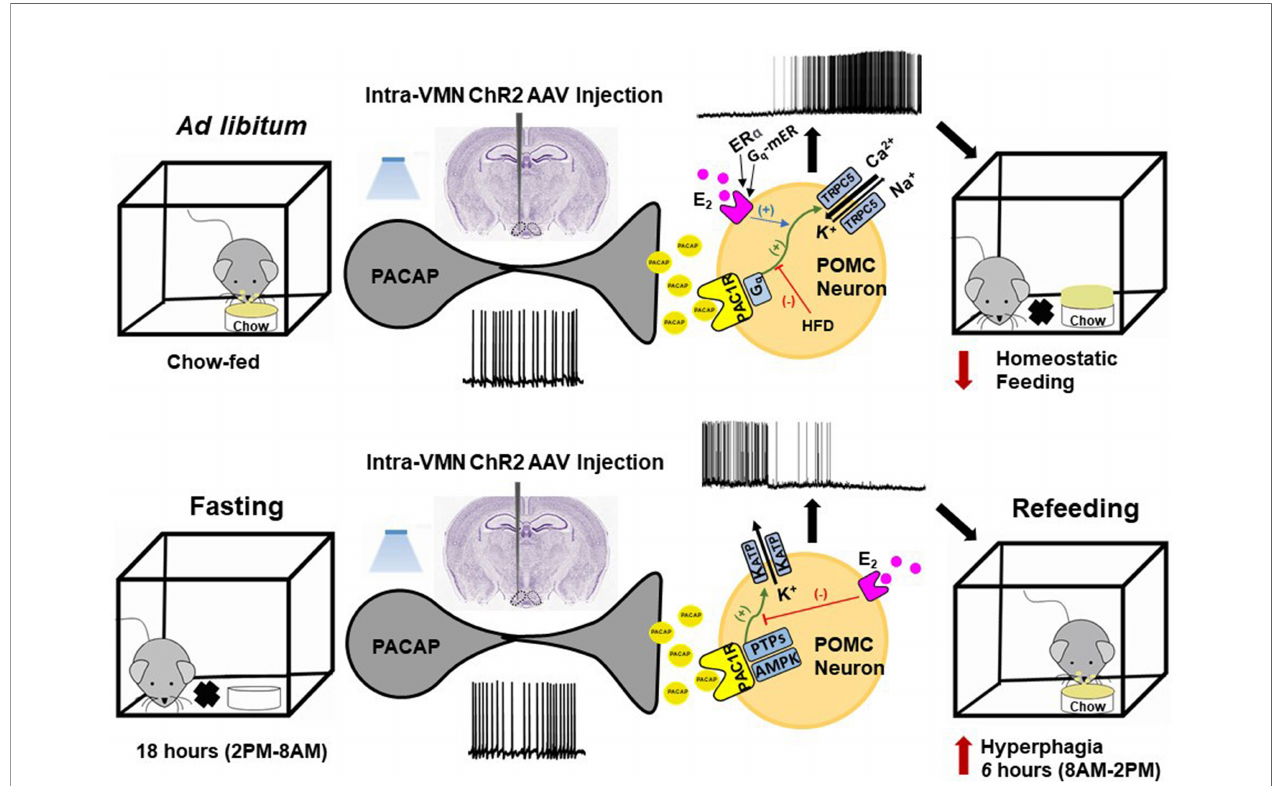
FIGURE 3 | Schematic overview of the energy status-dependent plastic changes in PAC1 receptor-mediated signaling at VMN PACAP/ARC POMC synapses. Top row , Under ad libitum -fed conditions, optogenetic stimulation of VMN PACAP neurons and subsequent release of PACAP stimulates PAC1 receptors in ARC POMC neurons, which in turn activates TRPC5 channels via G q -mediated signaling. This depolarizes the POMC neurons and increases their fi ring, and ultimately decreases homeostatic feeding. These effects are potentiated by membrane-initiated estrogenic signaling via ER a and G q -mER in females, and diminished by DIO in males. Bottom row , Under fasting conditions, PAC1 receptor/effector coupling in POMC neurons switches from TRPC5 channels to K ATP channels via upregulation of AMPK and protein tyrosine phosphatases (PTPs) like PTP1B and TCPTP. This hyperpolarizes the POMC neurons and suppresses their fi ring; ultimately enhancing the rebound hyperphagia that occurs during